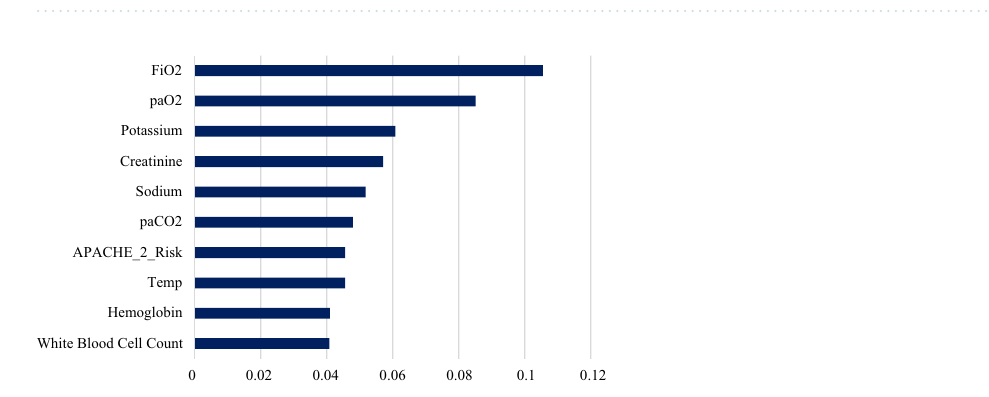
Figure 3. Predictor importance chart for decision tree, potential of hydrogen (pH), Fraction of inspired oxygen (FiO 2 ).